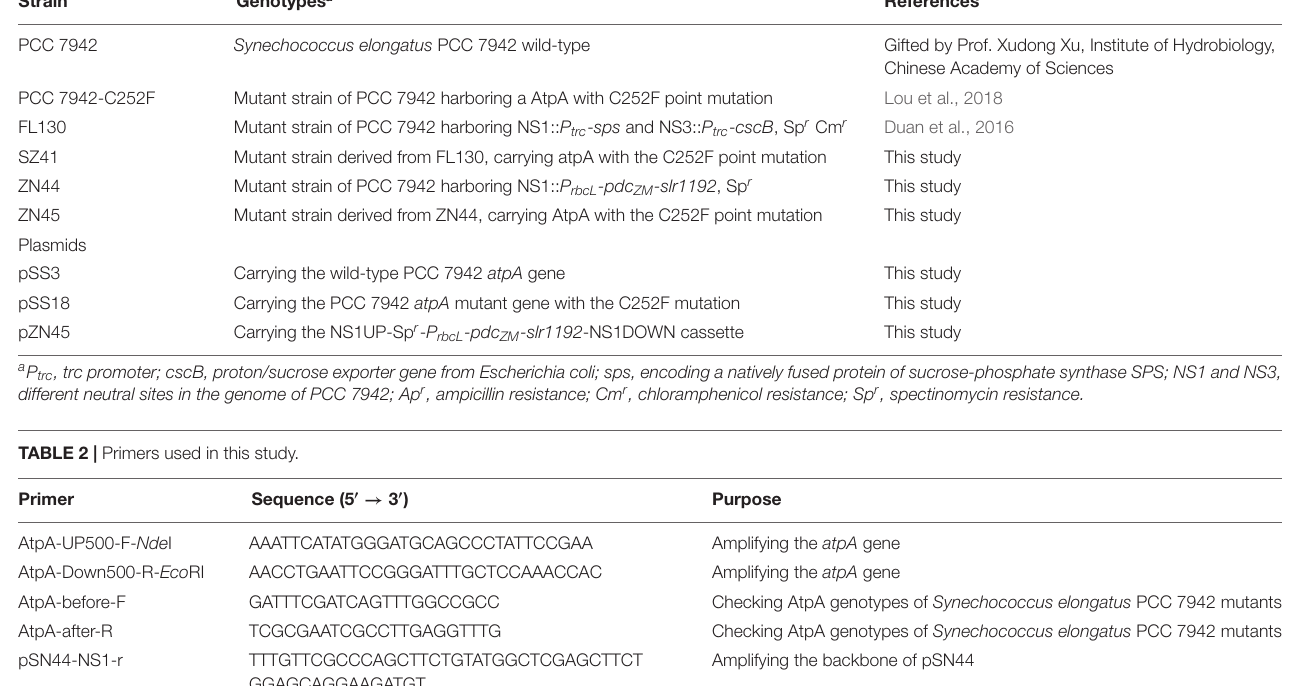
TABLE 1 | Cyanobacterial strains and plasmids used in this study. Strain Genotypes a